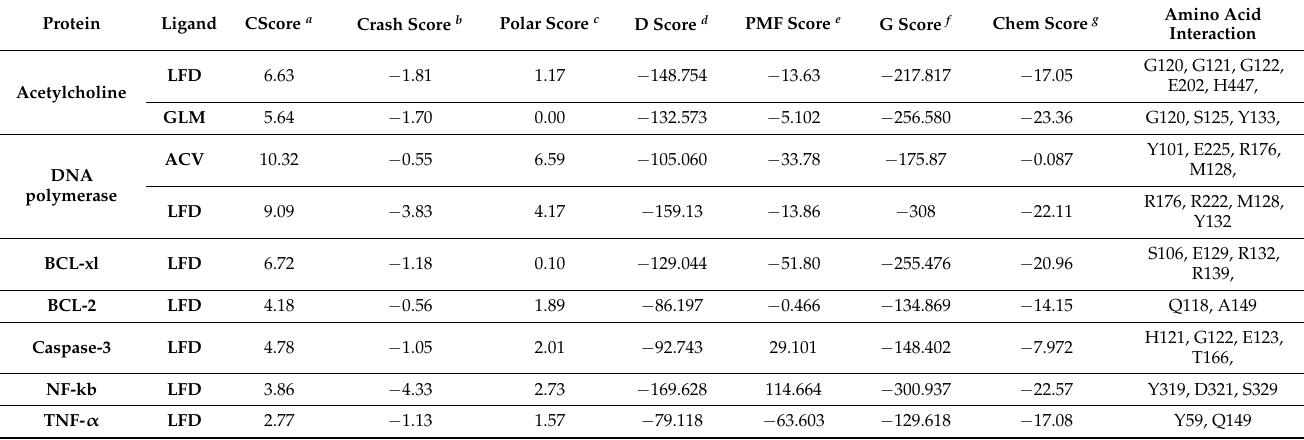
Table 2. Docked ligands Surflex scores LFD, GLM and ACV in distinct protein binding site.